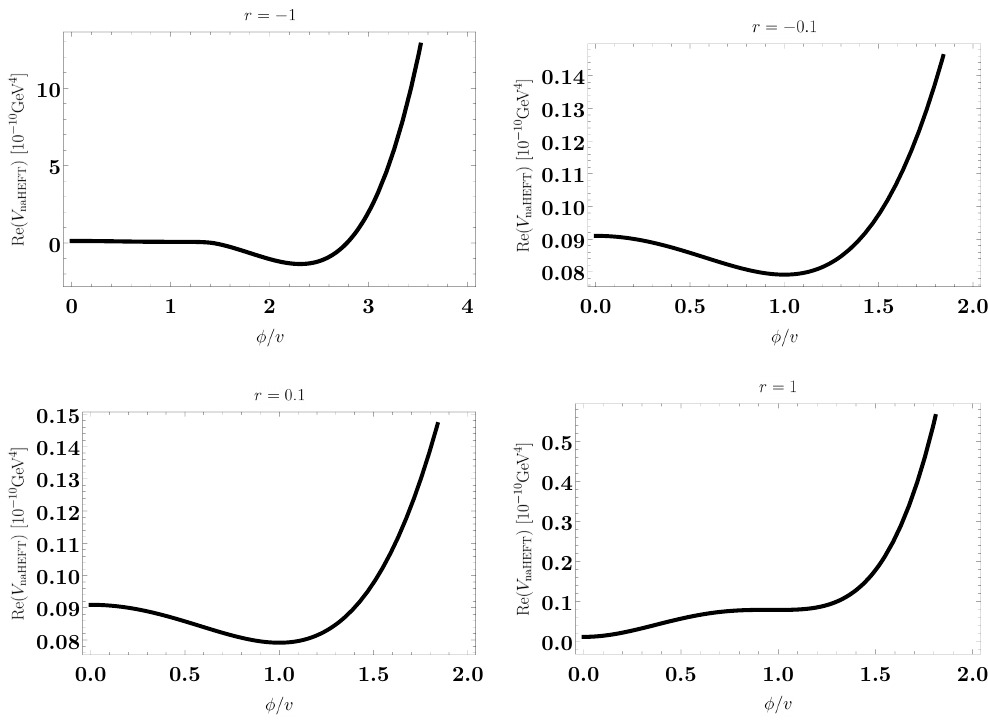
Figure 3 . The real part of V naHEFT (eq. (3.3)). We take Λ = 1 TeV and κ 0 = 1